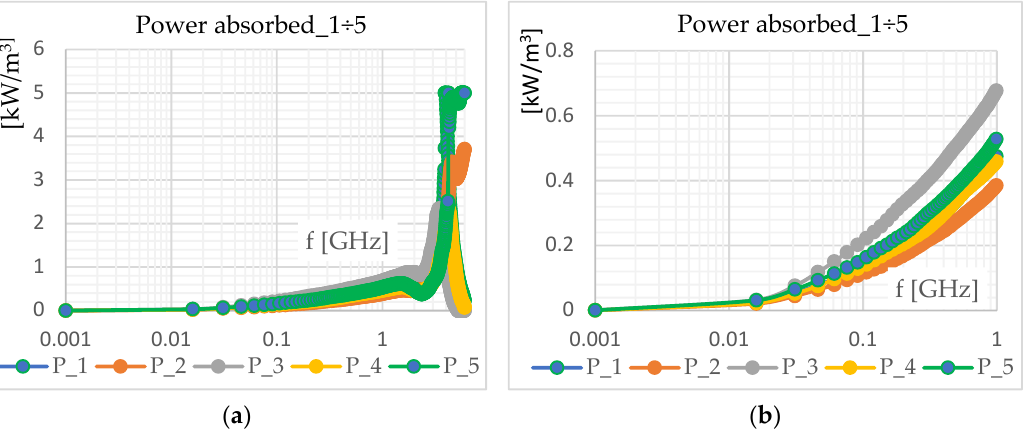
Figure 6. Dissipation factor tg δ for samples #1 ÷ #5 and the following ranges of f: ( a ) 1 MHz ÷ 6 GHz, ( b ) 1 MHz ÷ 1 GHz.